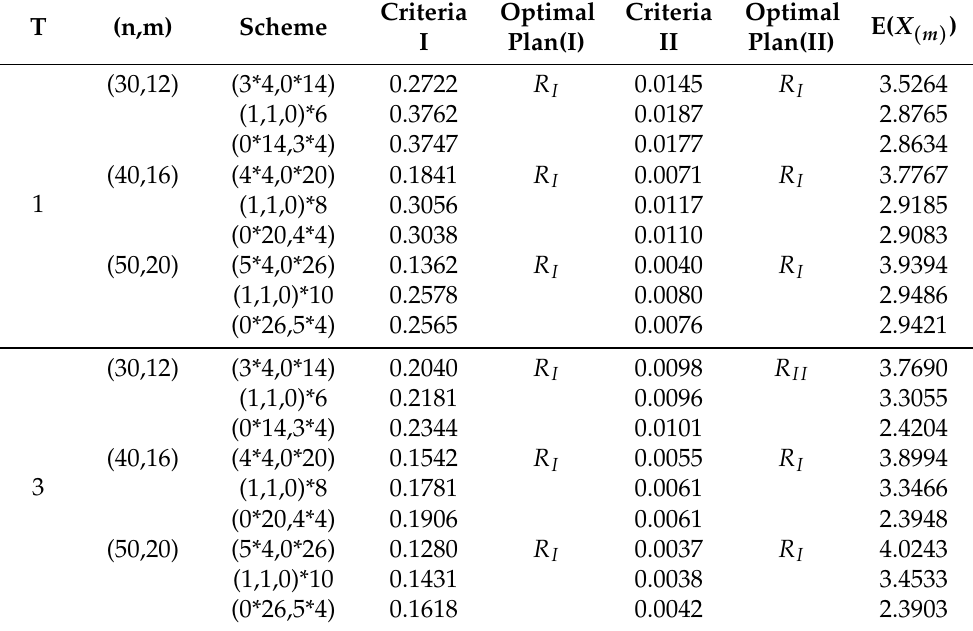
Table 8. Total expected time and optimal censoring schemes under different criterion. T